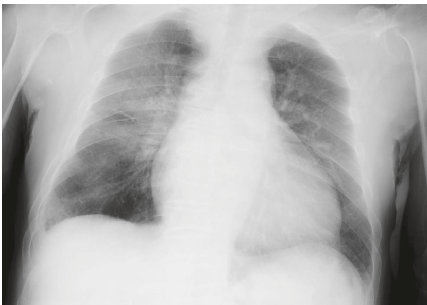
Figure 1: Chest X-ray findings on admission. Image shows alveolar opacity in both lungs, particularly in upper and middle lobes.